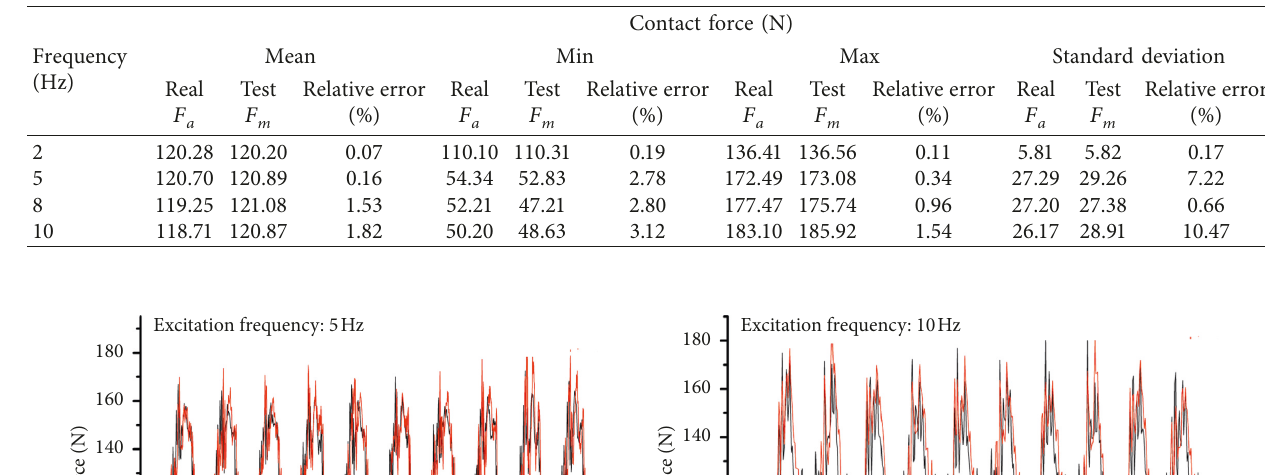
Table 1: Statistical results of contact forces in dynamical test.